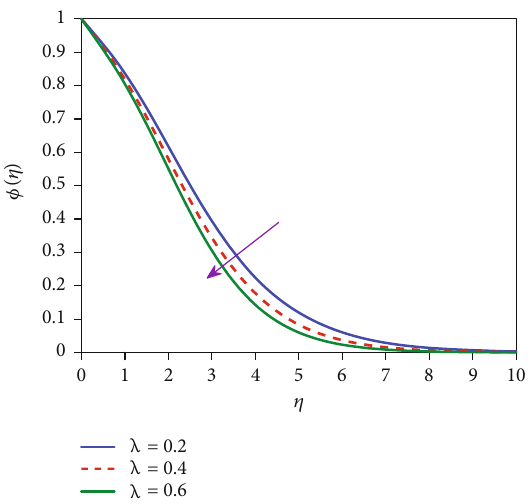
Figure 19: E ff ect of λ on the secondary velocity g ð η Þ